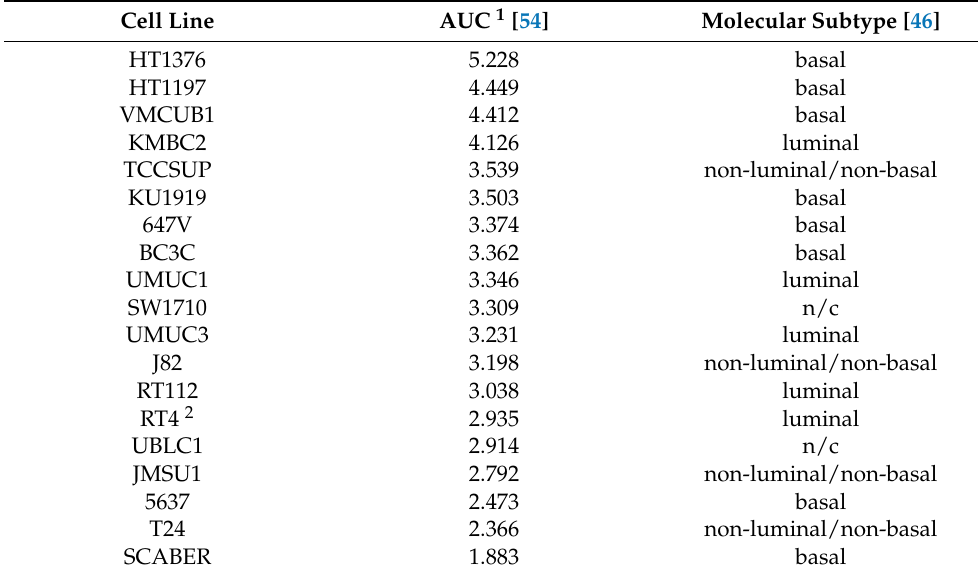
Table 2. Intrinsic radiosensitivity of a panel of BCa cell lines reported by Yard et al., 2016